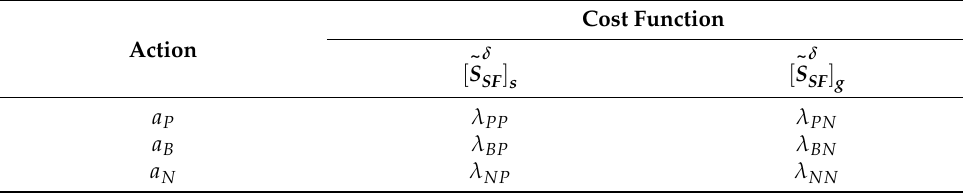
Table 1. Cost function